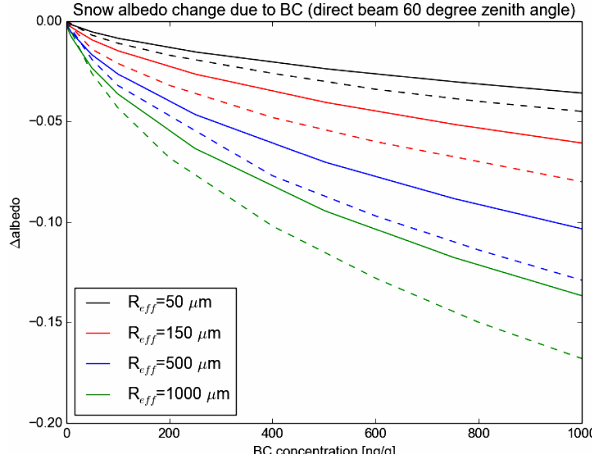
Figure 1. Response of snow albedo to the presence of BC, relative to pristine snow, for different snow grain effective radii. Full lines refer to simulations based on the approach by Cole et al. (2015) in CanAM4.2; dashed lines refer to results from simulations with SNICAR (Flanner et al., 2007,